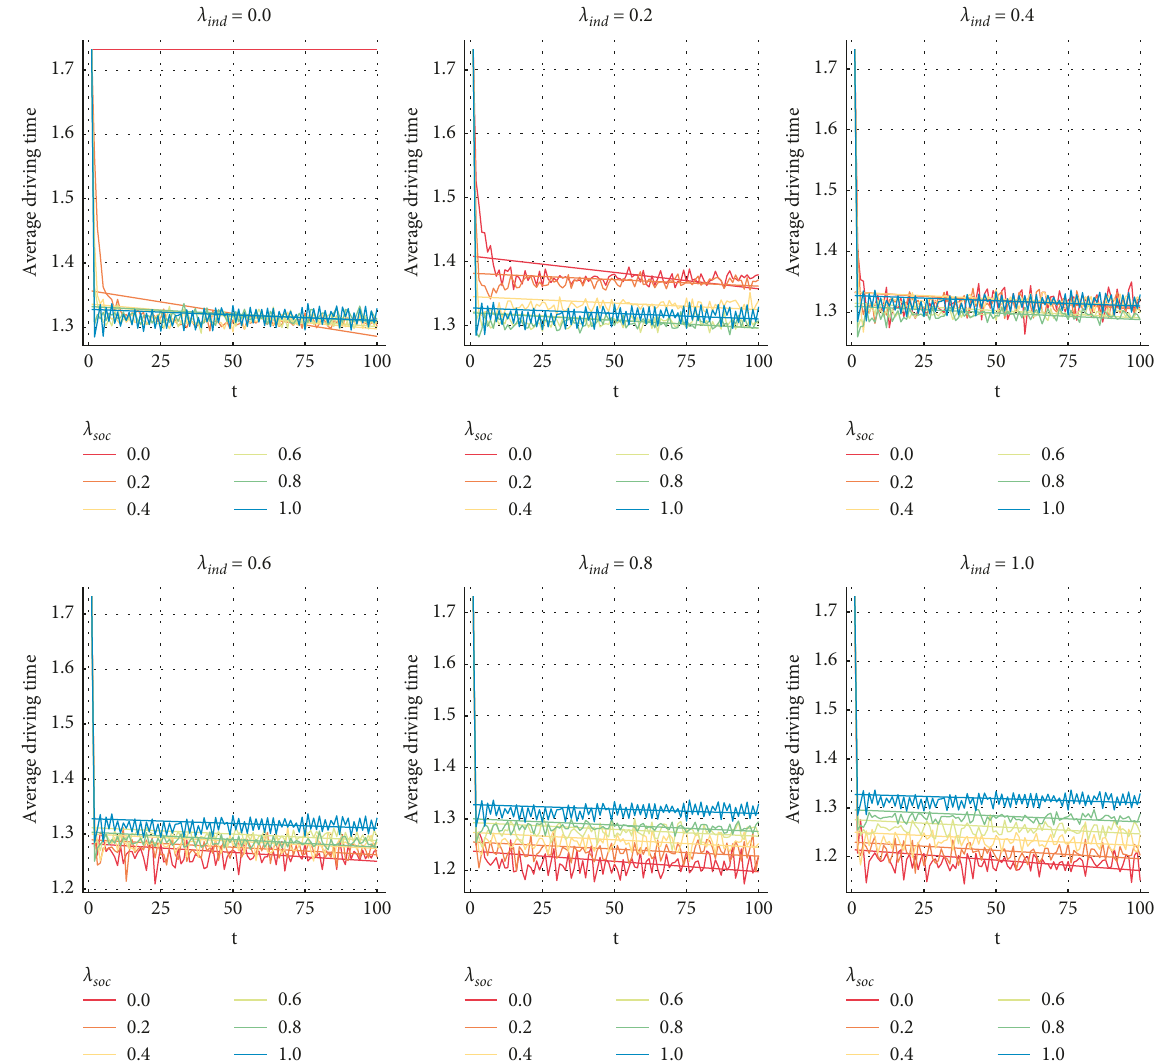
Figure 8: Changes of average driving times during the simulation for different combinations of λ